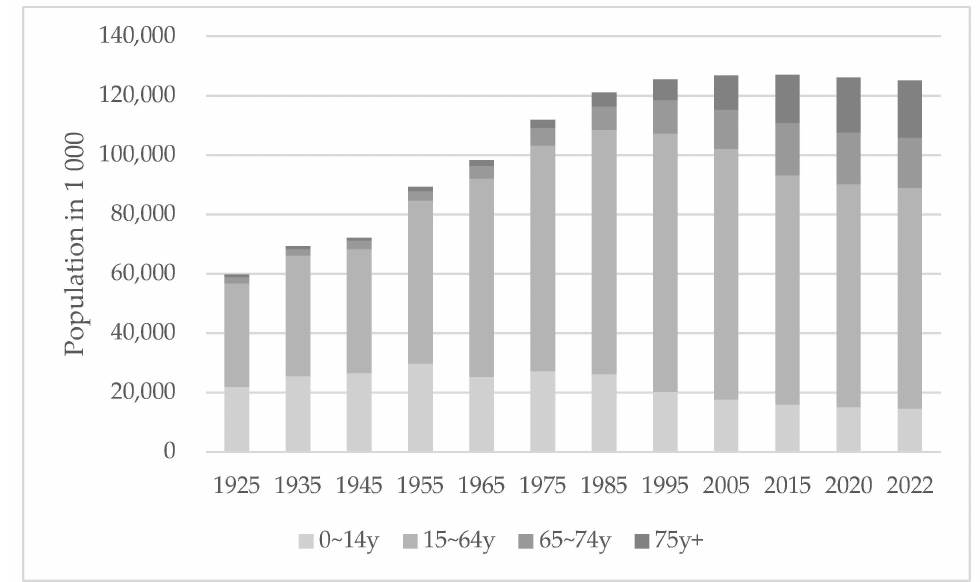
Figure 1. Population structure by age group in Japan (1925–2022). Data source: Ministry of Internal Affairs and Communications, Population Estimates (2022)